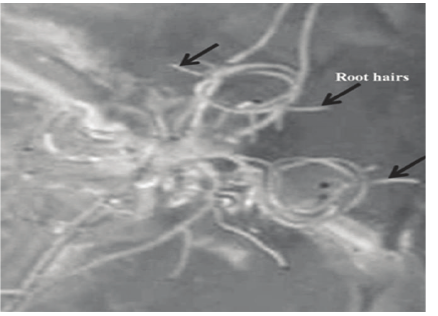
Figure 6: Growth of root hairs in S. aquimarina SjAM16103 inoculated explants of E . triplinerve ( in vitro ).